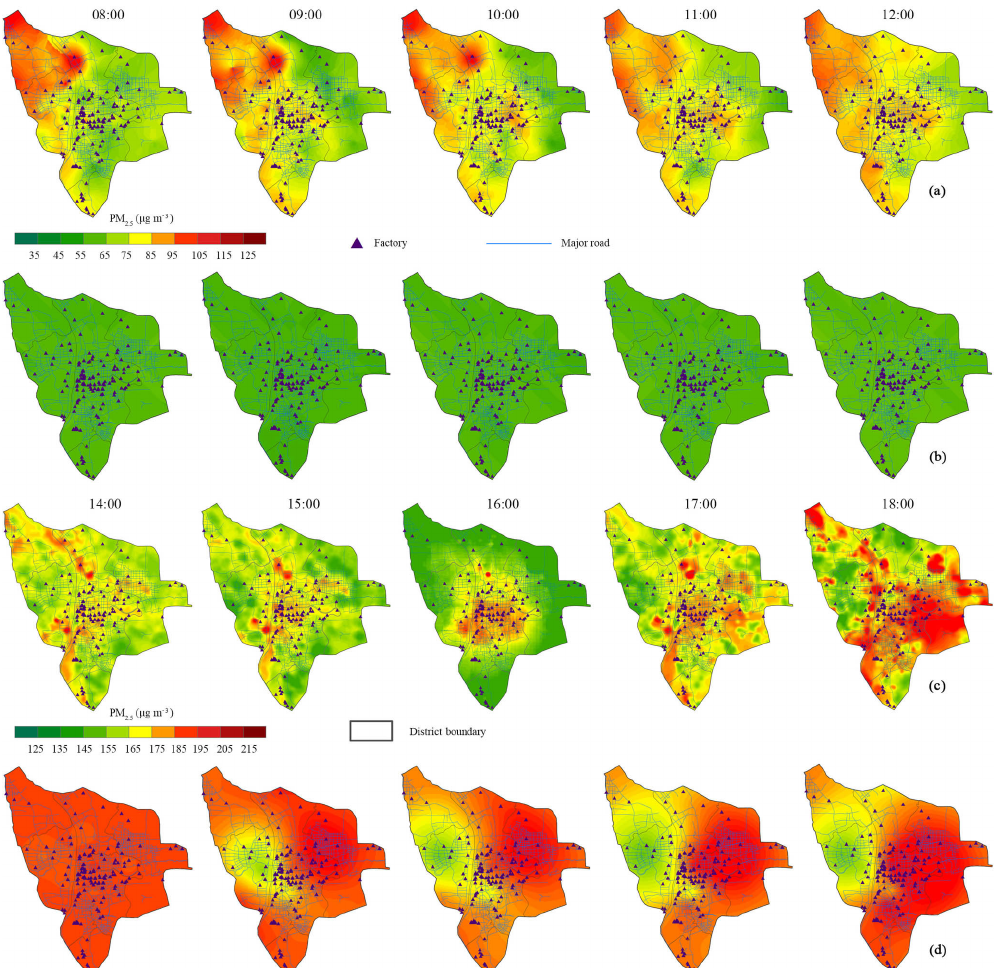
Figure 6. Spatial distributions of PM 2 . 5 concentrations from crowdsourced sampling sites and national monitoring stations. (a) Period 1, crowdsourced sampling; (b) Period 1, national monitoring; (c) Period 2, crowdsourced sampling; (d) Period 2, national